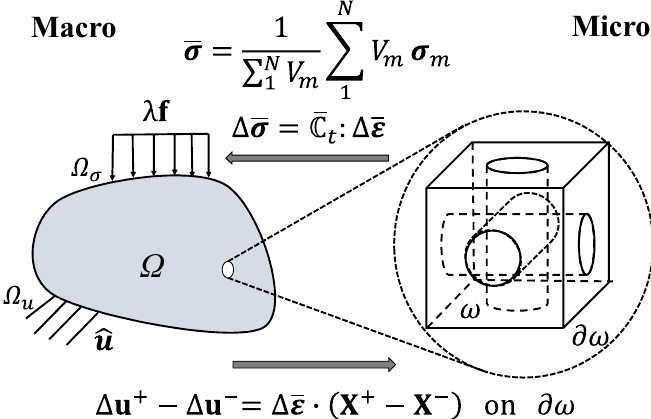
Figure 12. Basic concept of the finite element squared